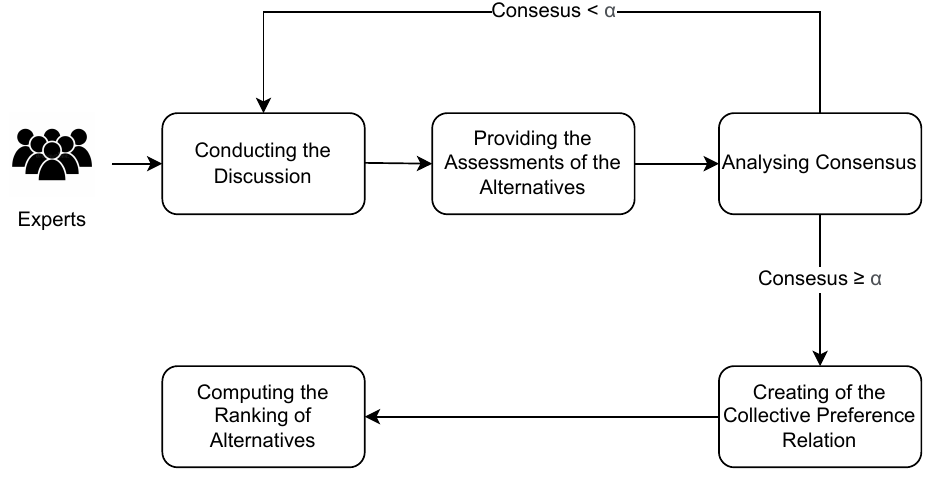
Figure 1. Basic diagram of a GDM